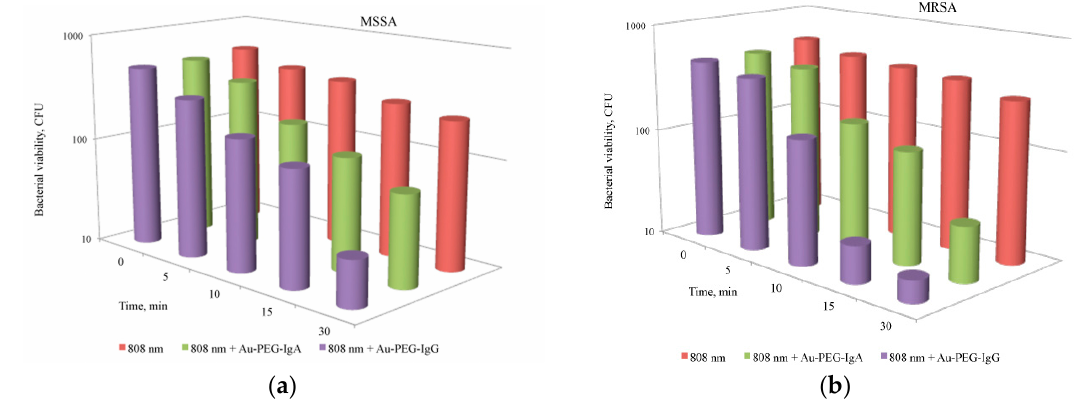
Figure 8. Action of NIR laser light (808 nm) and gold nanorods conjugates with immunoglobulin A and G on S. aureus survival rate: methicillin sensitive strain (MSSA) ( a ); methicillin-resistant strain (MRSA) ( b ). Red columns—laser light, green columns—laser light and AuNR3 with IgA, violet columns—laser light and AuNR3 with IgG.